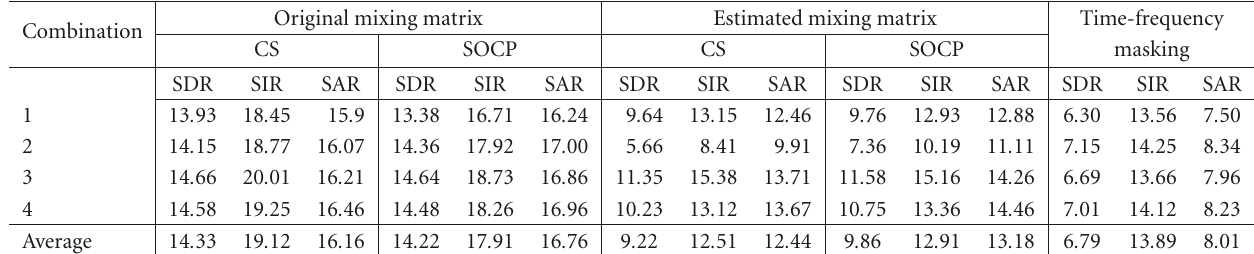
Table 4: Separation results for 4 sources (1, 3, 4, 6), 3 mixtures (1, 2, 3).